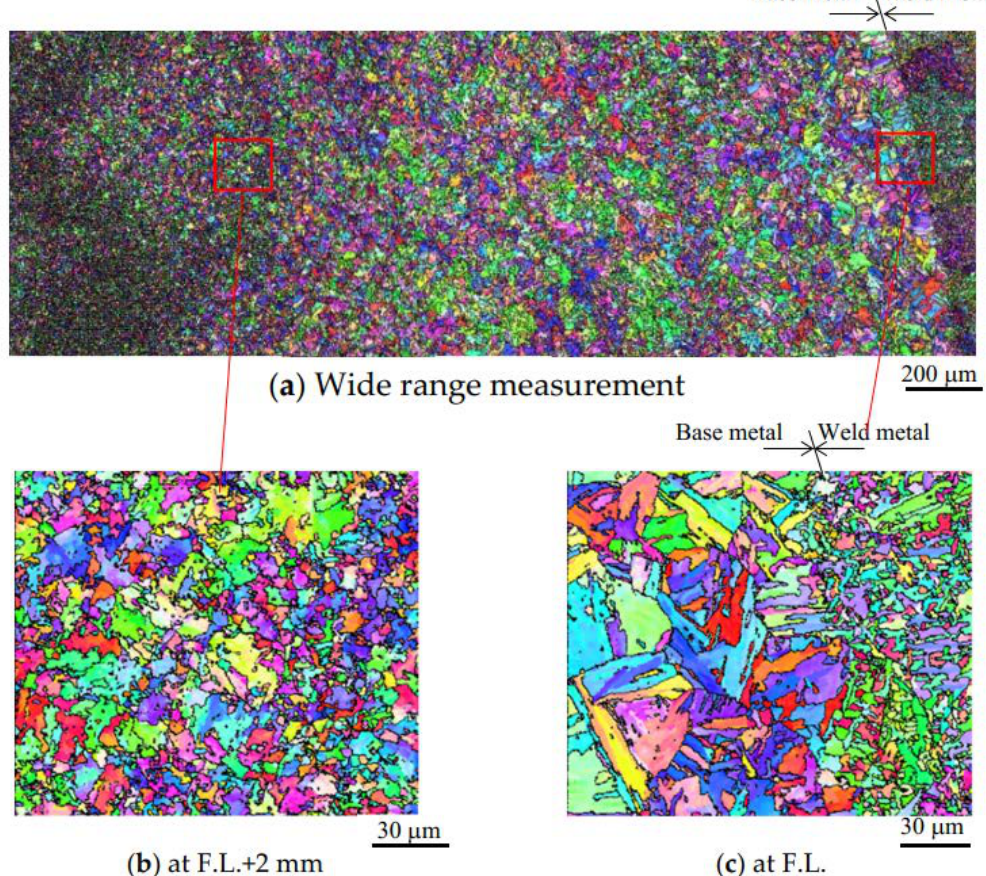
Figure 16. Inverse pole figure (IPF) maps with HAGB (black line) of weld joint ( a ) at the fusion line (F.L.) + 2 mm location ( b ) and the F.L. ( c ).